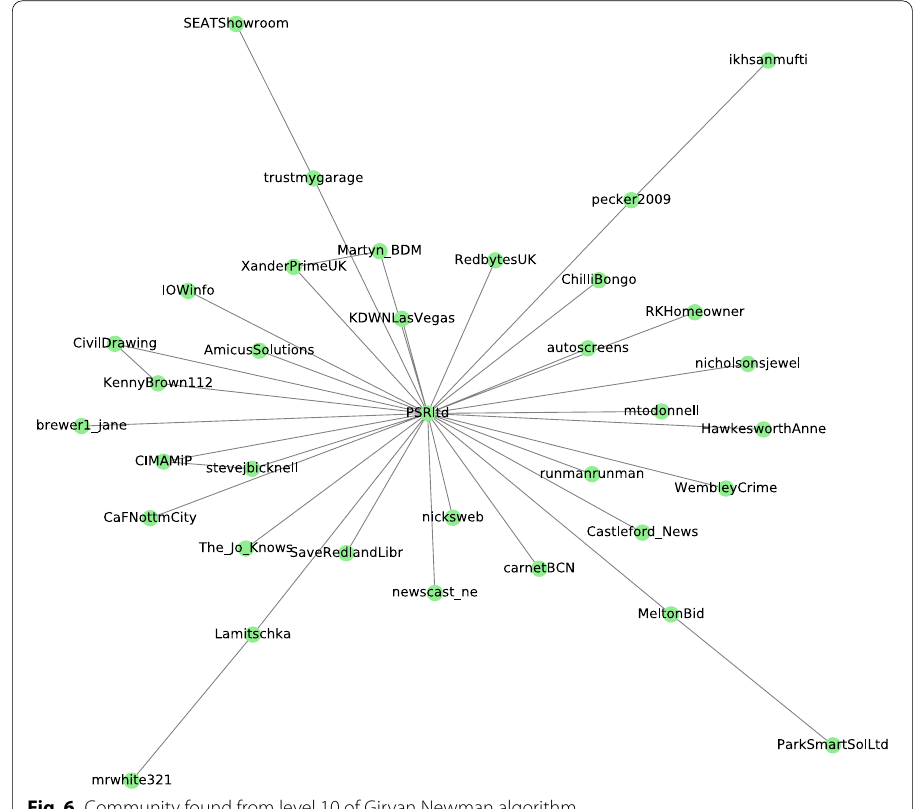
Fig. 6 Community found from level 10 of Girvan Newman algorithm